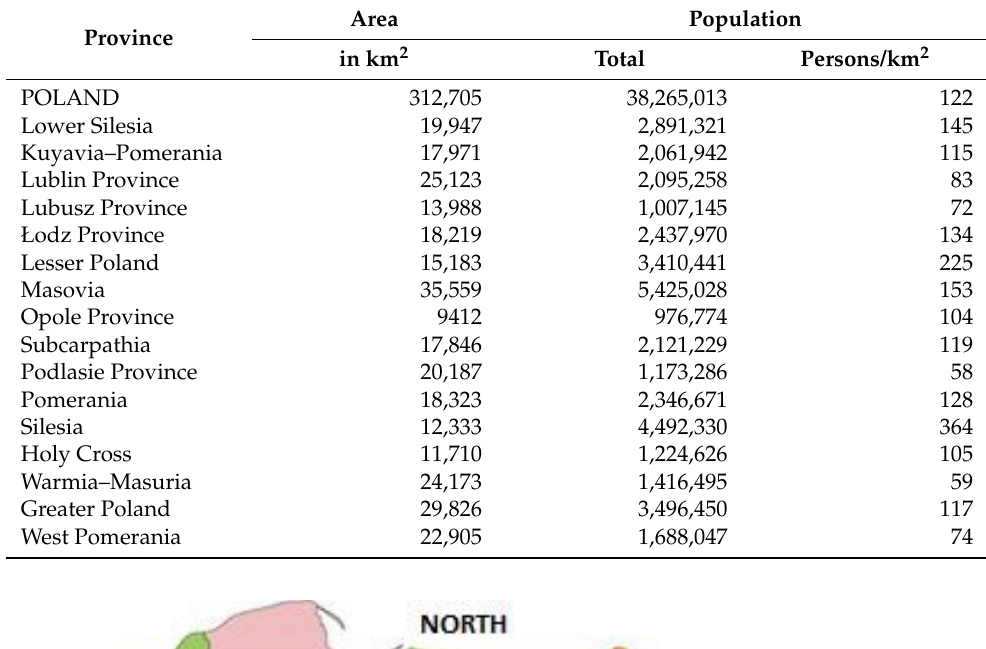
Table 1. Area, population by province in Poland in 2020 [62].